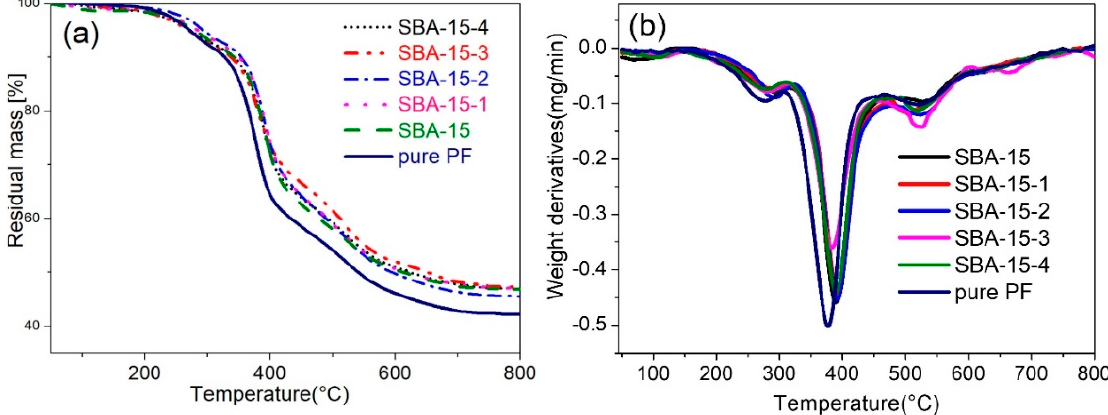
Figure 6. TGA ( a ) and DTG ( b ) curves for pure PF and SBA-15/PF hybrid. Table 2. Thermal decomposition of pure PF and SBA-15/PF enhanced by SBA-15 with different size of mesoporous.